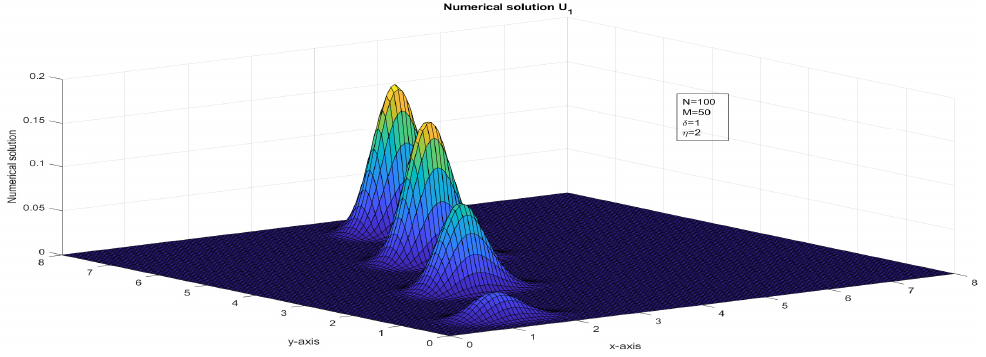
Figure 14. The surface plot illustrates the numerical solution, U 2 , for Case 2 in Example 1.